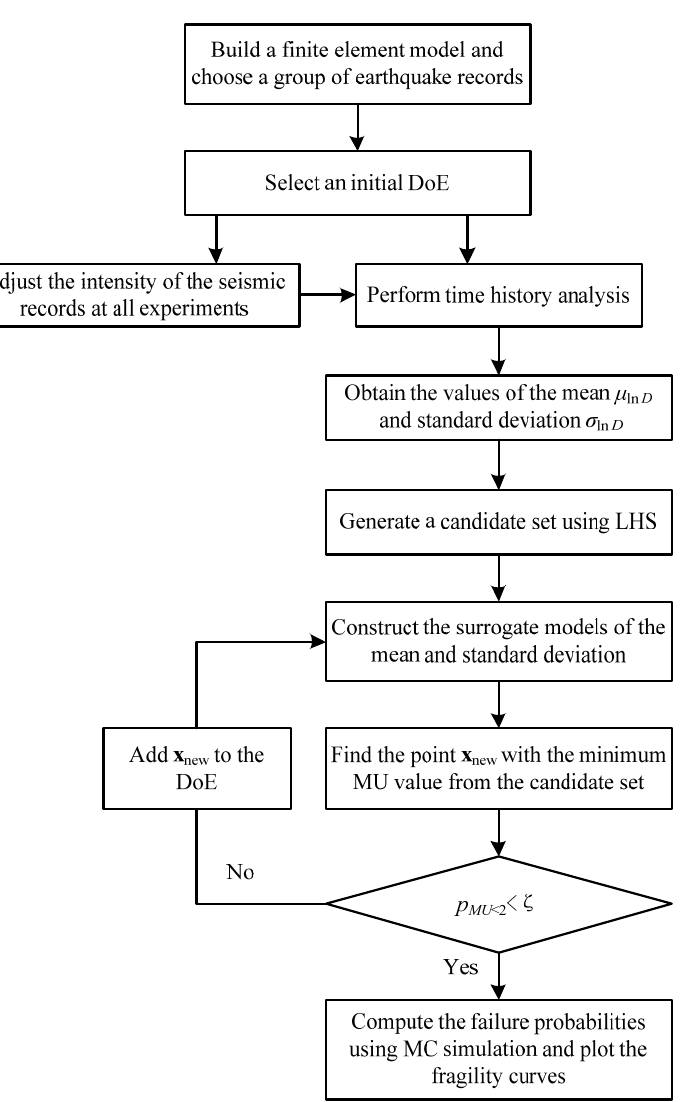
Figure 2. Flowchart of seismic fragility analysis.